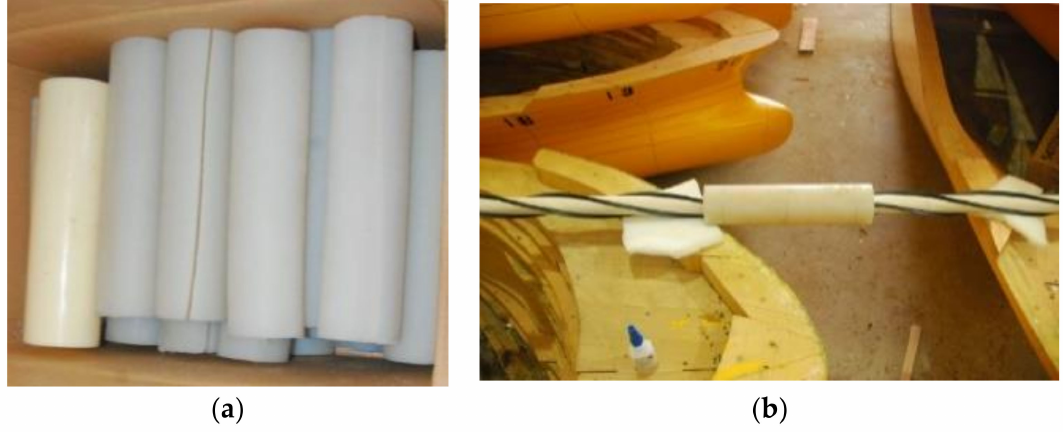
Figure 3. Models of buoyancy modules ( a ) and strakes ( b